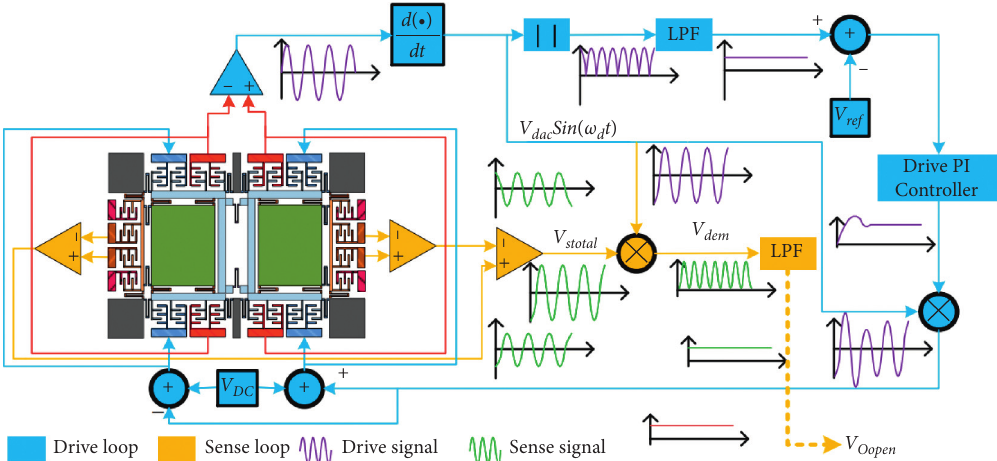
Figure 3: Gyroscope system schematic